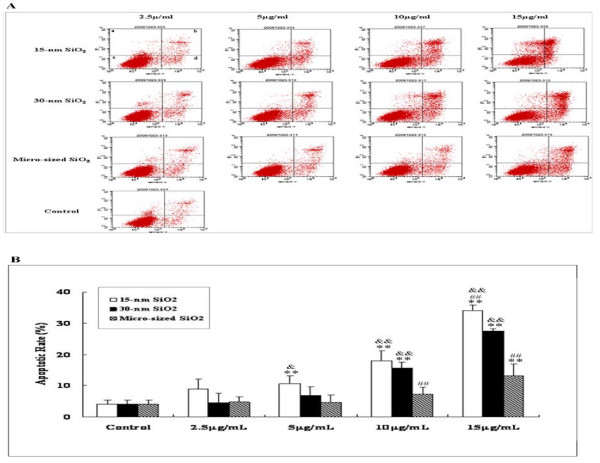
The effects of exposure to 15-nm, 30 nm or micro-sized SiO2 particles onon cellular apoptosis of HaCaT cells. A shows the representative images of apoptosis of HaCaT cells after 24-h exposure to 15-nm, 30-nm or micro-sized SiO2 particles at the dosages of 2.5 μg/mL, 5 μg/mL, 10 μg/mL or 15 μg/mL. B shows the quantitative results. Quadrant a, b, c and d denote the ratio of necrotic cells, late-stage apoptotic cells, normal cells, and early-stage apoptotic cells, respectively. Values were mean ± SD from three independent experiments. **p < 0.01 vs control cells; ##p < 0.01 vs cells exposed to 30-nm SiO2 particles; &p < 0.05, &&p < 0.01 vs cells exposed to micro-sized SiO2 particles.